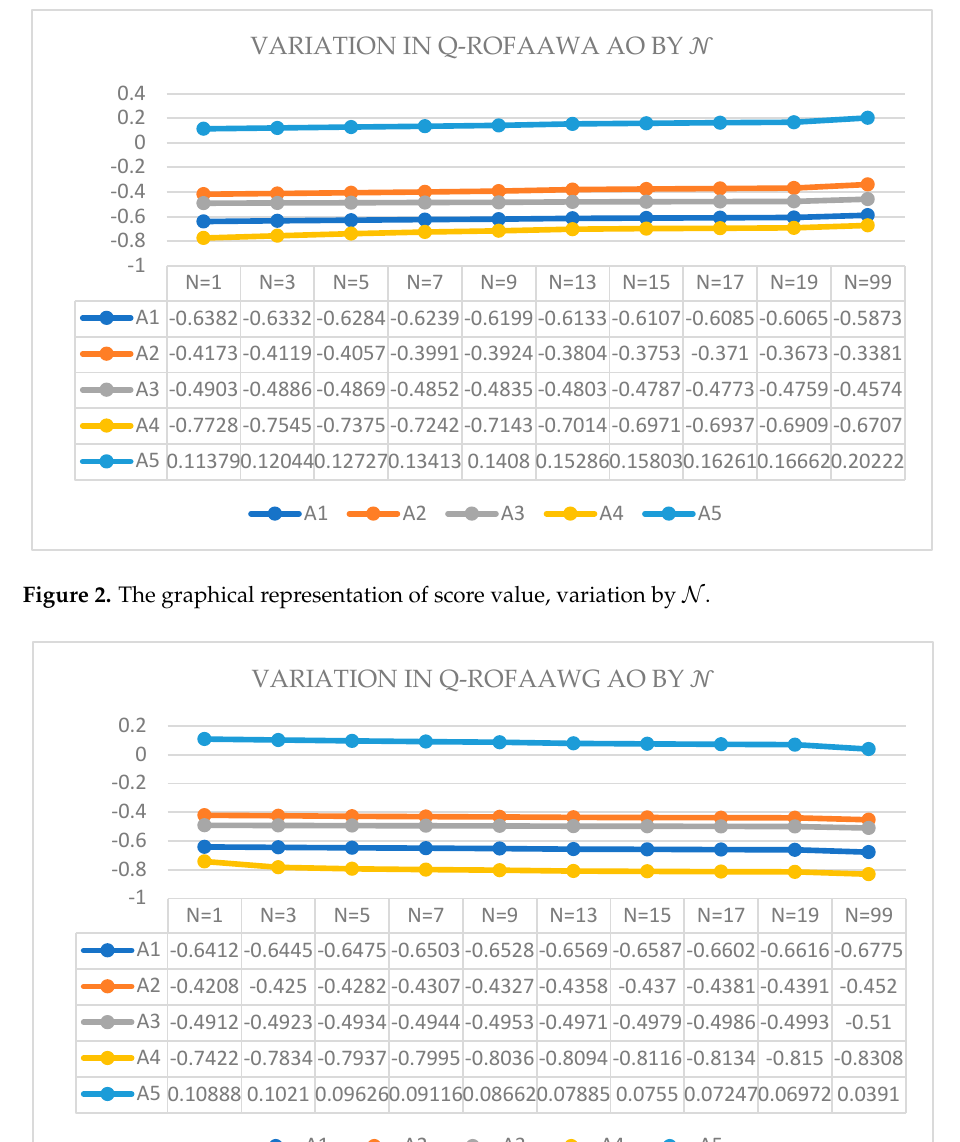
Figure 3. The graphical representation of score function, variation by 𝒩 , where the lines represent the raking of score value.